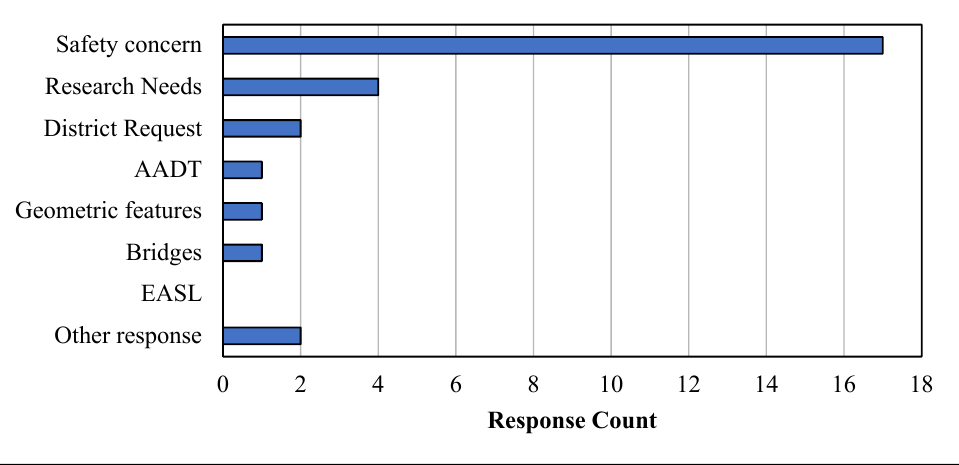
Figure 3. Selection criteria of testing pavement friction at specific locations.